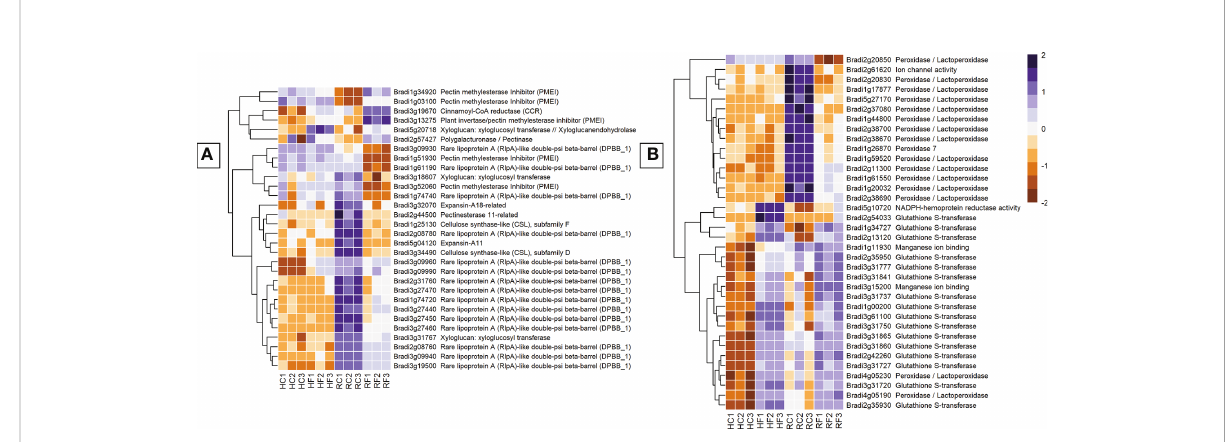
FIGURE 5 The most expressed or repressed cell-wall modi fi cation (A) and ROS-associated (B) B. distachyon genes. These genes showed a log-fold change of -3 ≤ Log2 ≥ 3 (A) and -5 ≤ Log2 ≥ 5 (B) with a p-adj < 0.05 in response to either FHB, FRR, or both. A more restrictive Log-fold threshold is used for (B) due to a larger number of signi fi cantly expressed or repressed ROS-associated genes. The scale bar on the right is the Z-score for all the heatmaps. Three biological replicates for each of the four treatments are displayed as columns abbreviated as HC (Head-FHB control), HF (Head-FHB fungus), RC (Root-FRR Control), RF (Root-FRR fungus). The control samples (HC1-HC3, RC1-RC3) are normalised transcript counts from mock inoculated head (Water with Tween 20) and root (PDA slurry) B. distachyon tissues and were separately analysed through the RNA-seq pipeline with the respective inoculated sample